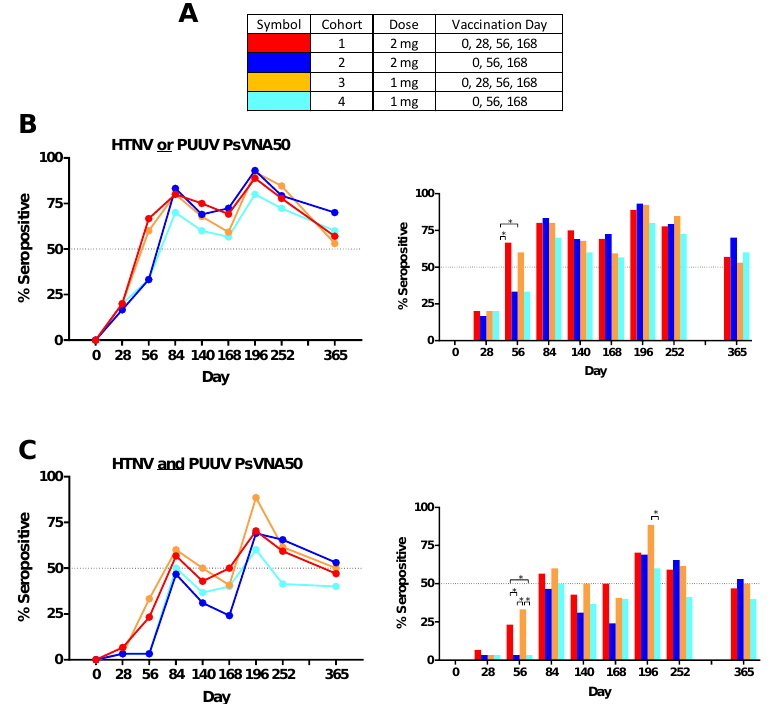
Figure 4. Seropositive to either HTNV or PUUV; or to both viruses. ( A ) Legend. ( B ) The percentage of subjects seropositive against either HTNV or PUUV at each timepoint were plotted as line graphs and bar graphs. ( C ) The percentage of subjects seropositive for both PUUV and HTNV at each timepoint was plotted. Percentages are based on the number of subject presenting non-missing data except day 365. The only subjects who returned for day 365 were the subpopulation that was still seropositive on the day 252 visit. * p -values from pairwise two-sided Fisher’s exact tests. Individual PUUV and HTNV PsVNA50 titers for each subject were plotted in Figure 2. The PsVNA50 GMT of the efficacy evaluable population for each cohort at each timepoint were calculated and plotted (Figure 5). GMT peaked after the first series of vaccinations (day 84) and then again after the day 168 boost (day 196) for both PUUV and HTNV. Although the titers dropped after day 196 they still remained greater than the preboost (day 168) titers for all four cohorts. The only significant differences between the cohorts were on day 56 and day 196 (Figure 5C). The difference between the cohorts receiving the DNA vaccine at the day 28 time point (cohorts 1 and 3) versus PBS vehicle alone (cohorts 2 and 4) on day 56 indicated that the day 28 immunization significantly increased the day 56 titers. The significant difference on day 196 was between cohort 3 and 4.